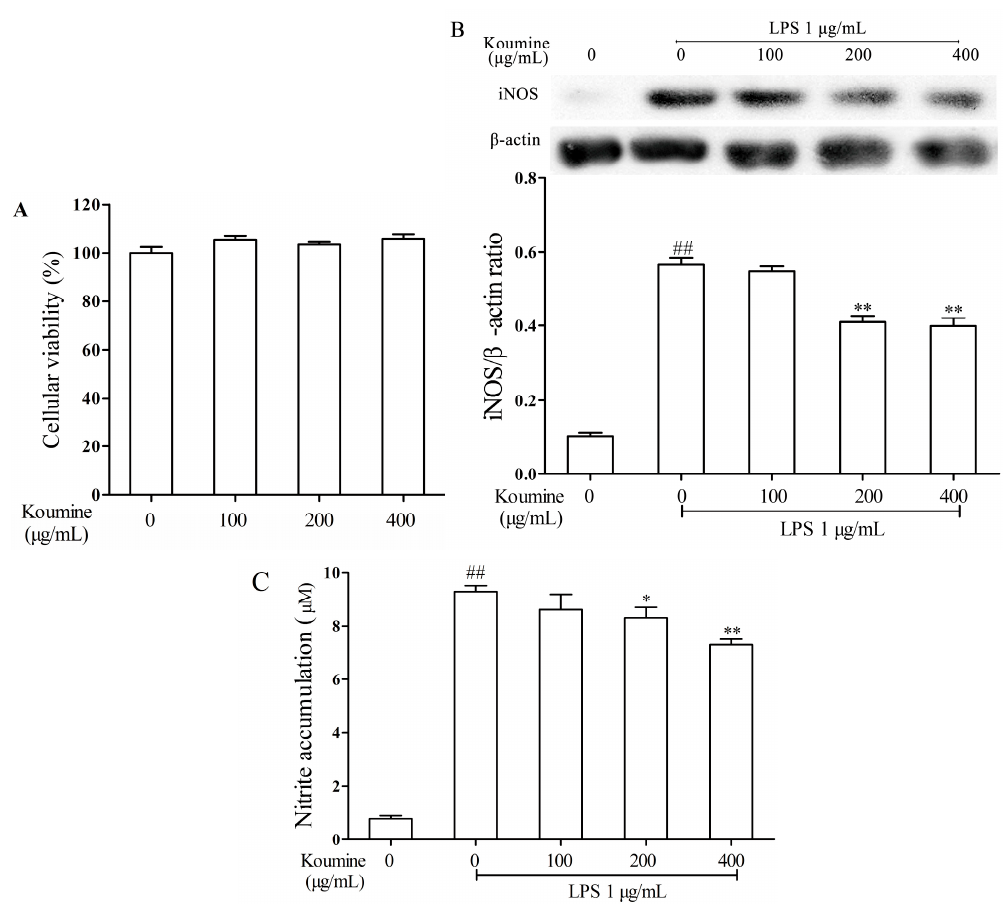
Figure 1. Effects of koumine on lipopolysaccharide (LPS)-induced inducible nitric oxide synthase (iNOS) and nitric oxide (NO) levels in RAW264.7 cells. ( A ) RAW264.7 macrophages (5 × 10 3 cells/well) were pre-incubated with 100, 200 or 400 μ g/mL koumine for 24 h. Cytotoxicity of koumine on RAW264.7 ( n = 5) was evaluated using MTT assay; ( B ) RAW264.7 macrophages (5 × 10 5 cells/well) were pre-exposed to 100, 200 or 400 μ g/mL koumine for 1 h. Subsequently, cells were treated with 1 μ g/mL LPS in pre-incubated mediums. After incubation for an additional 18 h, the protein levels of iNOS were determined by Western blotting; the quantification histogram of iNOS protein expression was normalized by β -actin. ( n = 3); and ( C ) Culture media were isolated and the culture supernatants were collected for NO detection by Griess reagent. The data were expressed as mean ˘ standard deviations (SD) ( n = 3). ## p < 0.01 vs. control group; * p < 0.05 and ** p < 0.01 vs. LPS